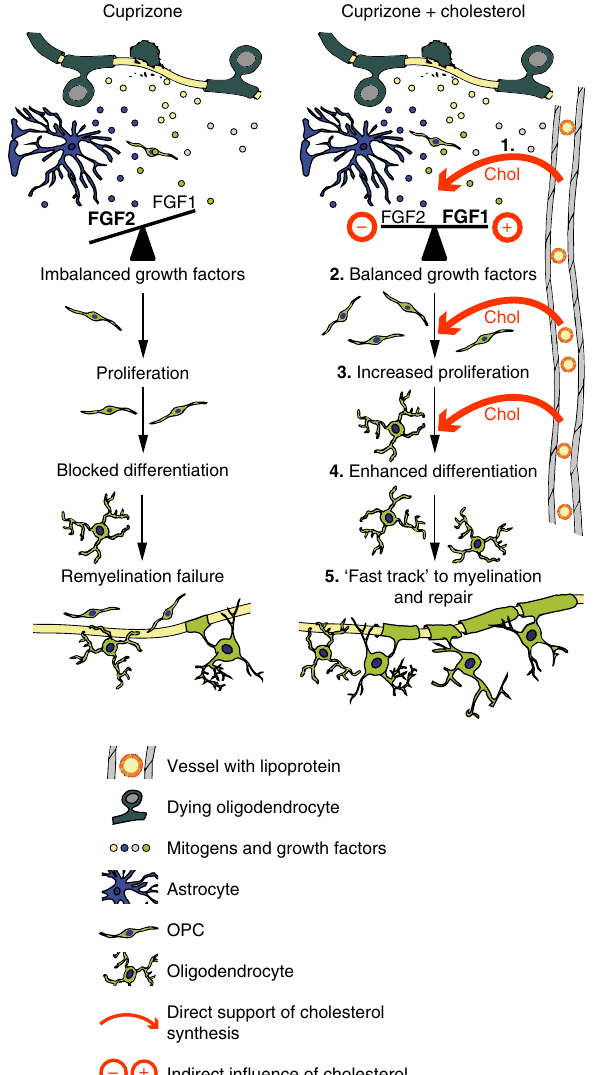
Figure 8 | Working model of repair processes influenced by cholesterol. Working model of nutritional cholesterol mediated repair processes. Cuprizone exposure causes oligodendrocyte loss and demyelination and slow repair (left panel) because of OPC depletion, imbalanced growth factors, and low local availability of cholesterol. In case of nutritional supplementation, cholesterol from the circulation enters the CNS because of increased BBB permeability (red arrows) increasing the local cholesterol availability (1). There, cholesterol rebalances the expression of growth factors and mitogens synthesized e.g. by astrocytes (2). This simultaneously enhances OPC proliferation (3) and opens a window for OPC differentiation. Cholesterol directly facilitates oligodendrocyte differentiation, presumably by relieving cells from time and energy intensive cholesterol synthesis (4). Altogether, these effects provide a ‘fast track’ to remyelination and repair